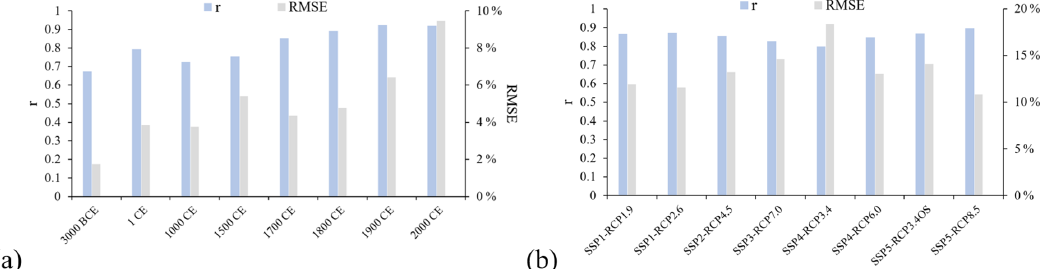
Figure 7. Comparison of cropland proportion in the corresponding pixels between our downscaled map and (a) HYDE 3.2 in the eight selected years and (b) LUH2 in 2100CE under eight future scenarios. Our downscaled maps were aggregated into 10km and 0.25 ◦ resolution for the two comparisons, respectively.